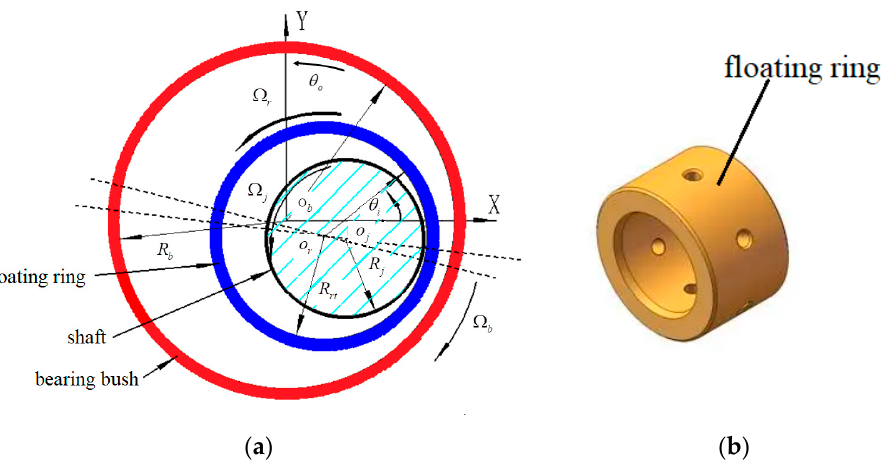
Figure 2. Schematic diagram of bearing: ( a ) schematic diagram of floating ring bearing; ( b ) floating ring model. According to the theory of Capone modified short bearing, the dimensionless ana-